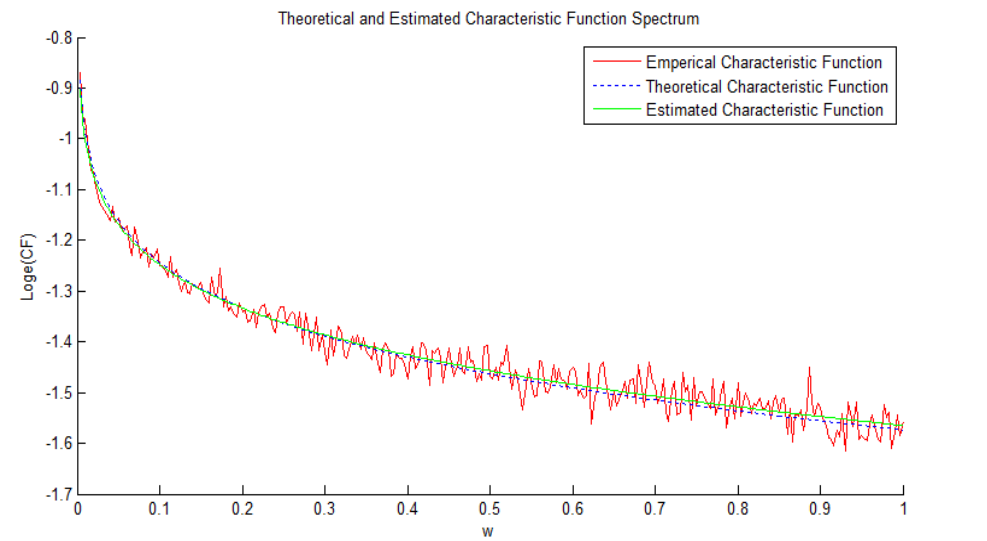
Figure 3 the comparison of theoretical, empirical and estimated characteristic function